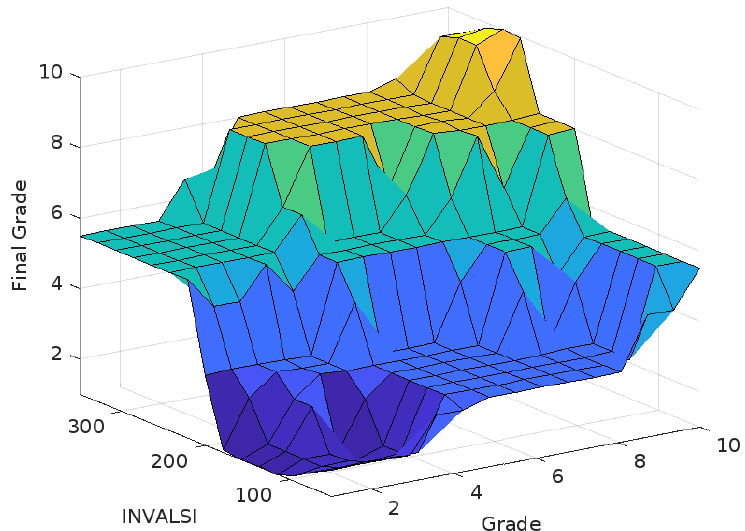
Figure 6. The output surface for the fuzzy inference system, plotting the output variable “Final Grade” against the first two input variables, i.e., “INVALSI” and “Grade”.